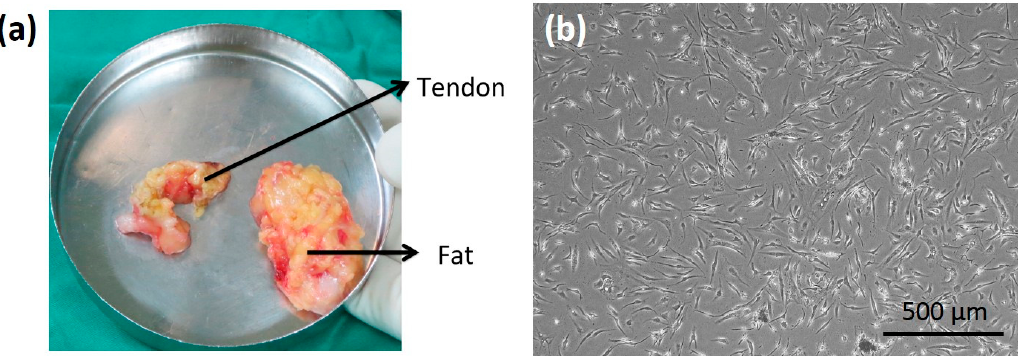
Figure 1. ( a ) Photograph of the harvested fat tissue. ( b ) Microscopic image of the first passage of adipose-derived stem cells (ADSCs).